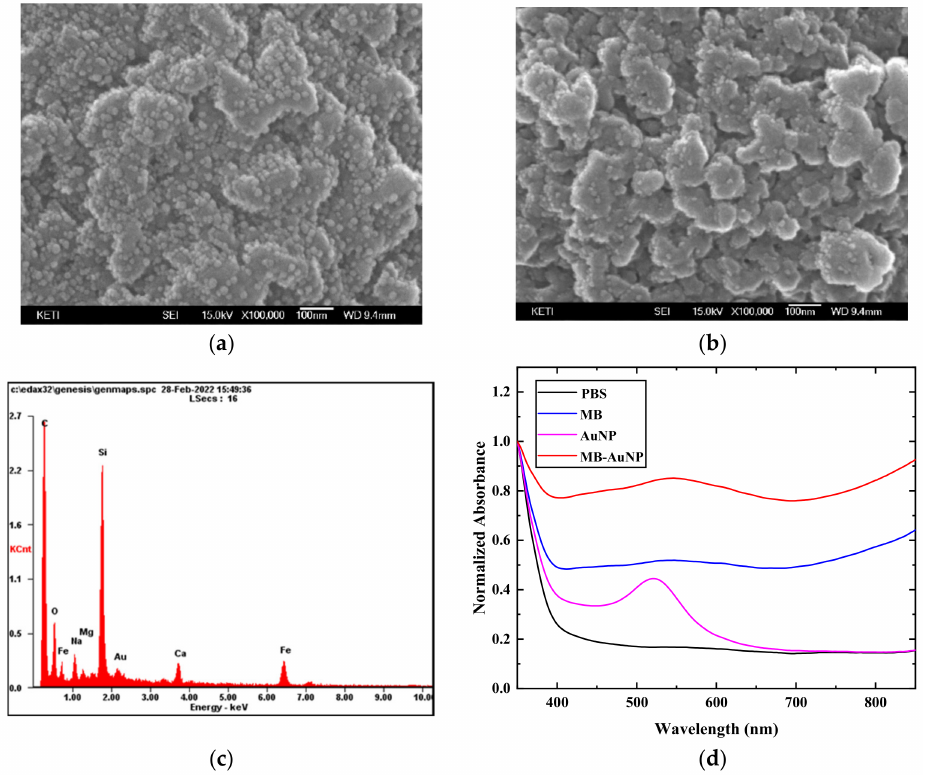
Figure 2. SEM/EDX analysis and UV–Vis absorption spectrum of AuNP-MB complex (AMB): ( a ) SEM image of AMB; ( b ) SEM image of MB; ( c ) EDX data of AMB; ( d ) UV–Vis absorption spectrum of the AMB, MB, and